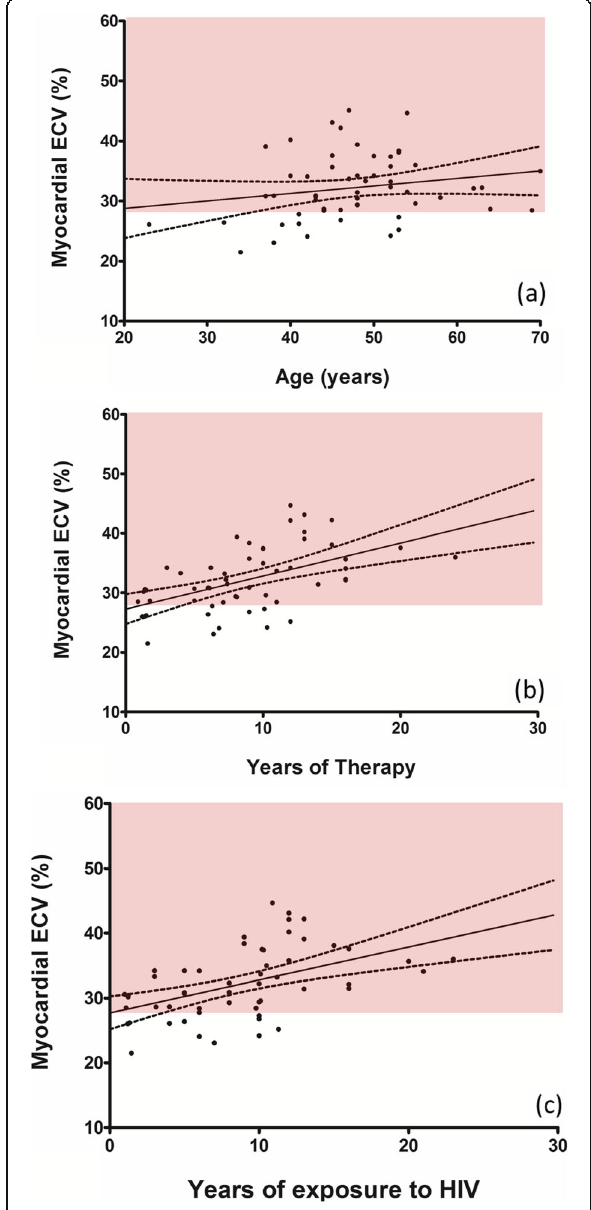
Fig. 2 Scatter plots and best-fit regression curves (Solid line) with 95% CI bands (shown as dashed lines) of ECV versus age ( a ), years of therapy (b ), and years of exposure to HIV ( c ) are shown for HIV+ patients. r and p-value are also reported. Red shading denotes the ECV range of the disease zone. Reference intervals are defined from the work of Scully et al.